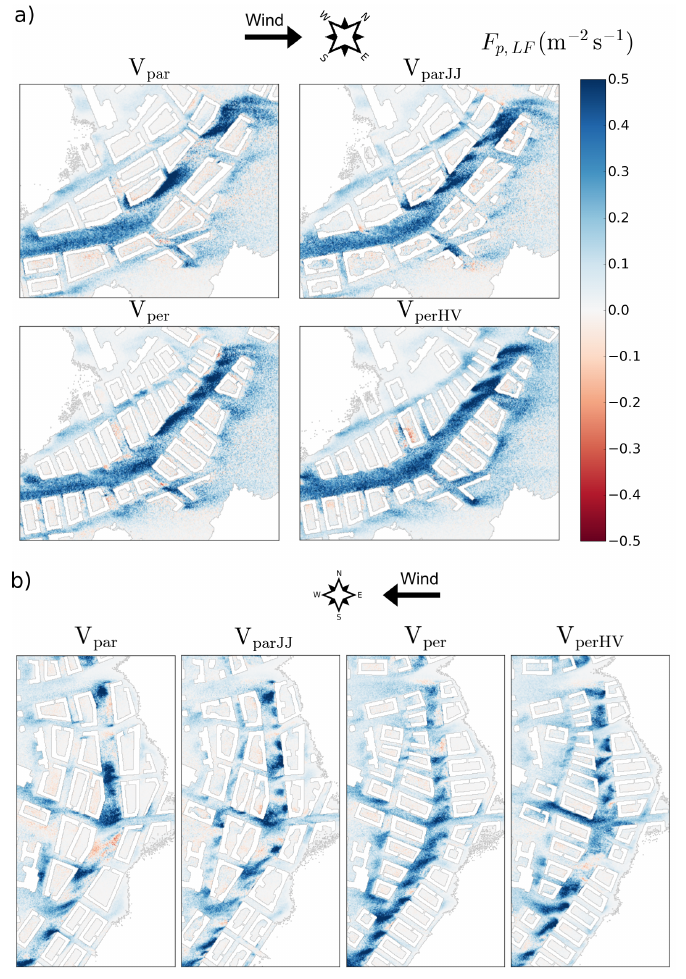
Figure 11. 40-min mean low-frequency vertical turbulent particle flux density F p , LF (m − 2 s − 1 ) at z = 20 m under the ( a ) general and ( b ) wintry inflow conditions. Positive values indicate upward flux.